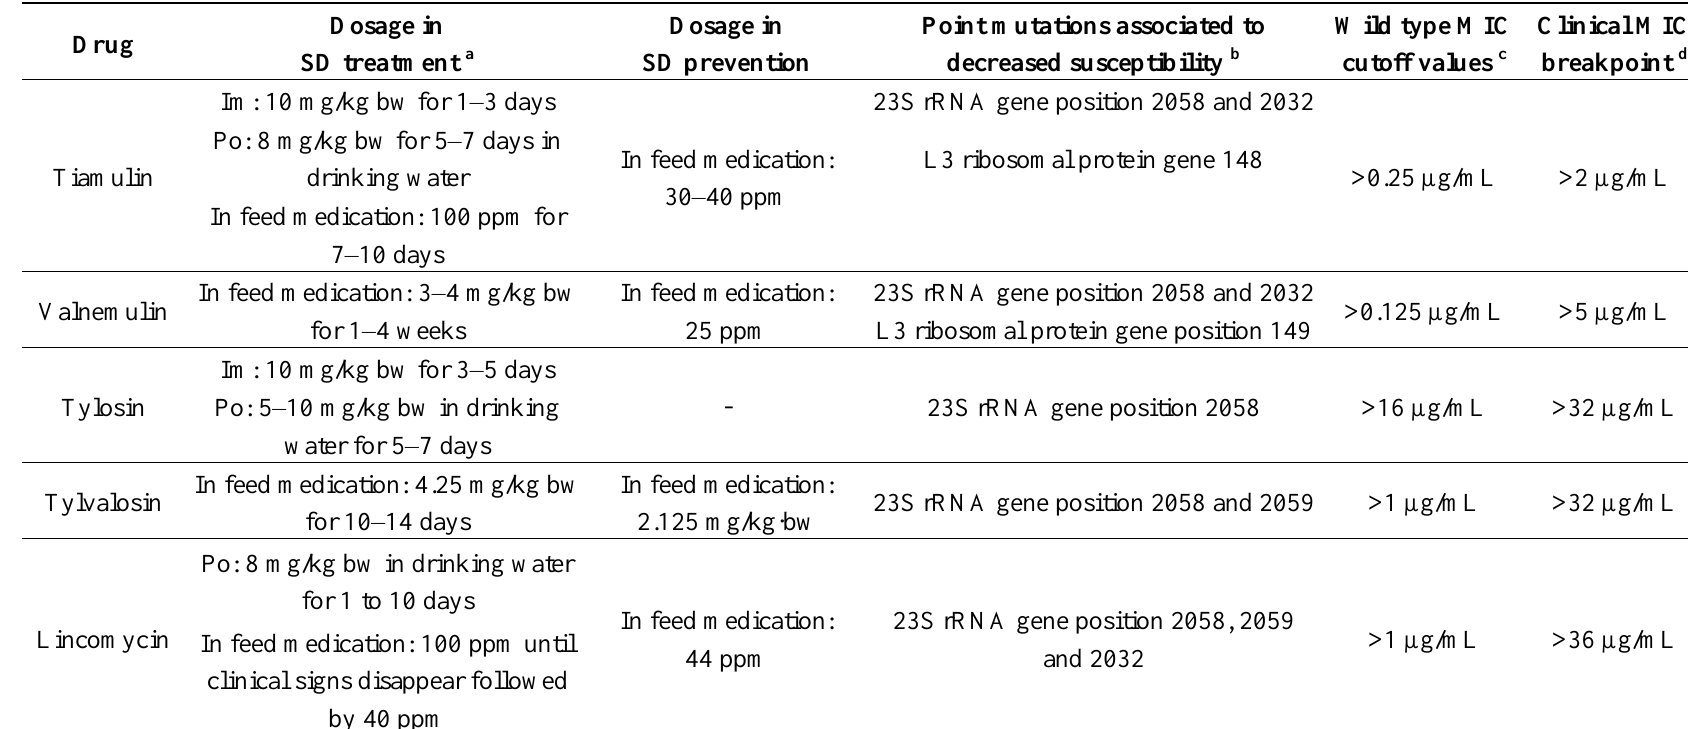
Table 1. Main antimicrobials used for the treatment and prevention of swine dysentery (SD).